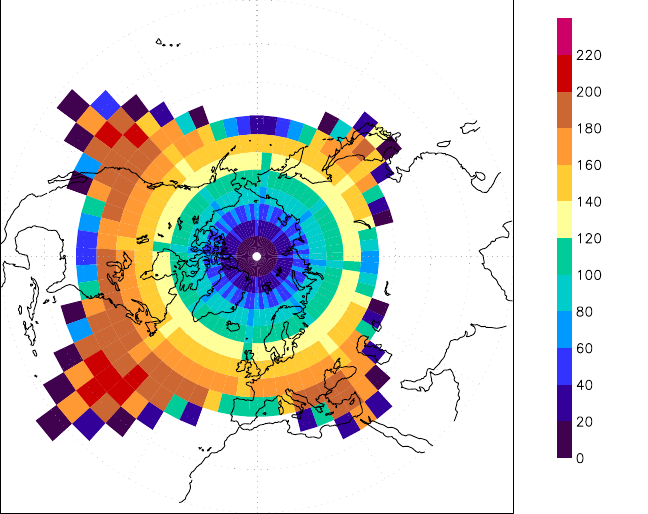
Figure 3. Altitude differences on the ECBilt grid of the maximum height of the GRISLI cells contained in the same ECBilt cell for the two reference topographies shown in Fig. 1. Colour scale is given in